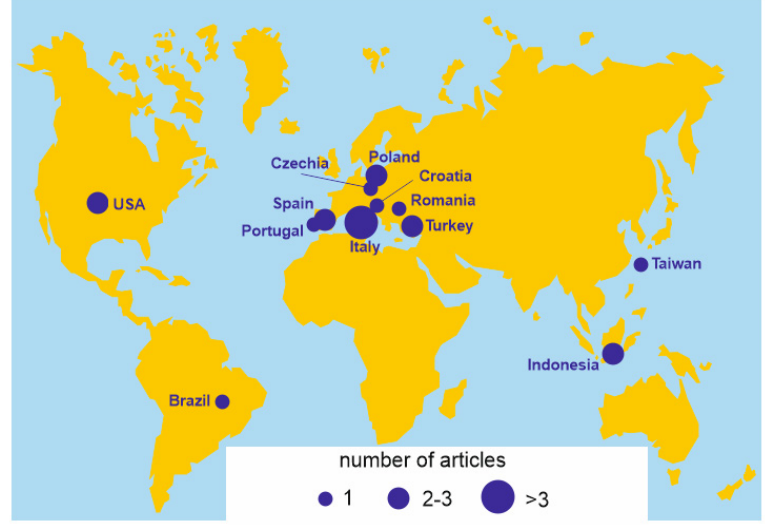
Figure 2. Geographical focus of the research in geoheritage and climbing activities.